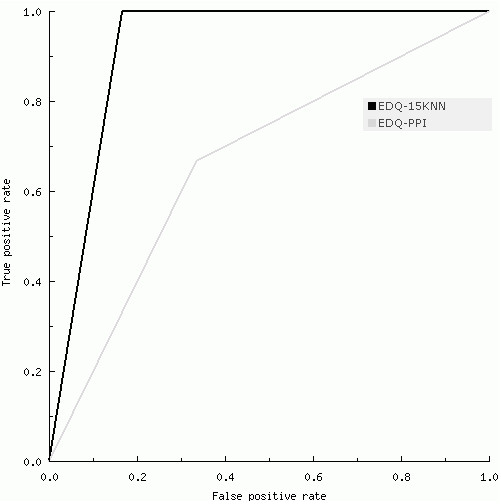
ROC curves for representative prediction models. Models compared: EDQ+15NN, EDQ and EDQ+PPI.